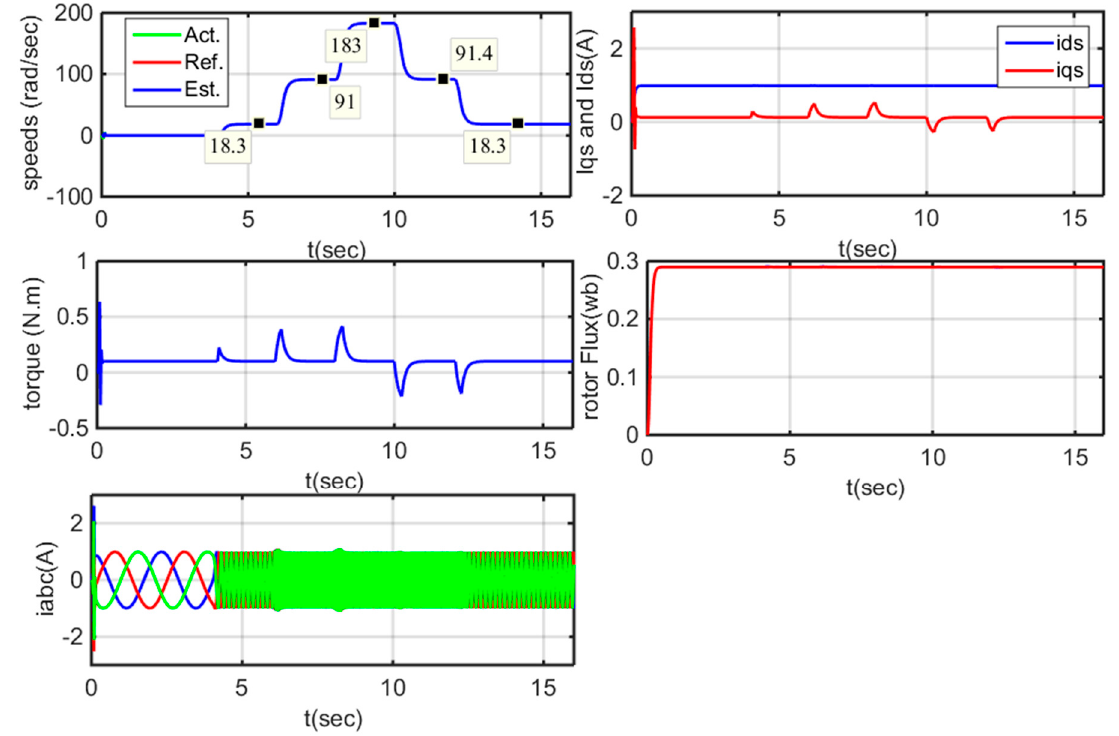
Figure 11. Simulation results of the acceleration and deceleration operation using the proposed sensorless drive system.